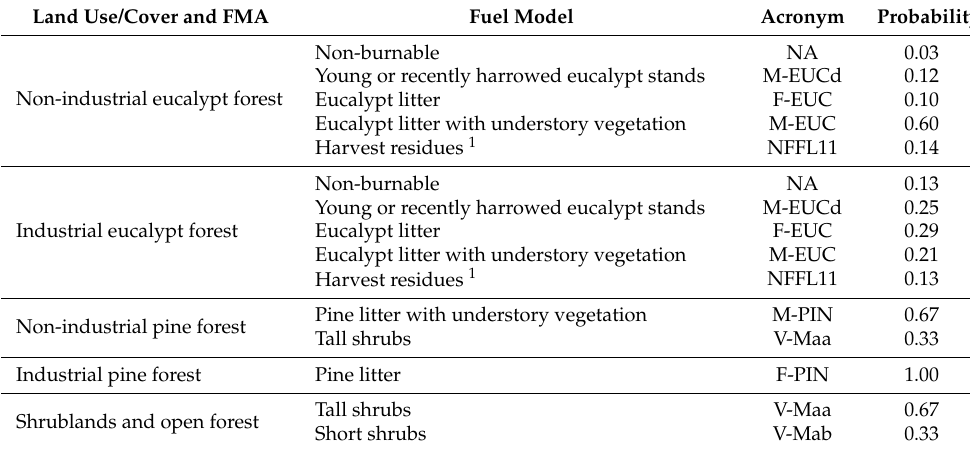
apply. Table 1 summarizes fuel model probabilities for the major land cover types and uses in the study region. Table 1. Fuel model probability distribution for each main land use/cover type and forest manage- ment approach